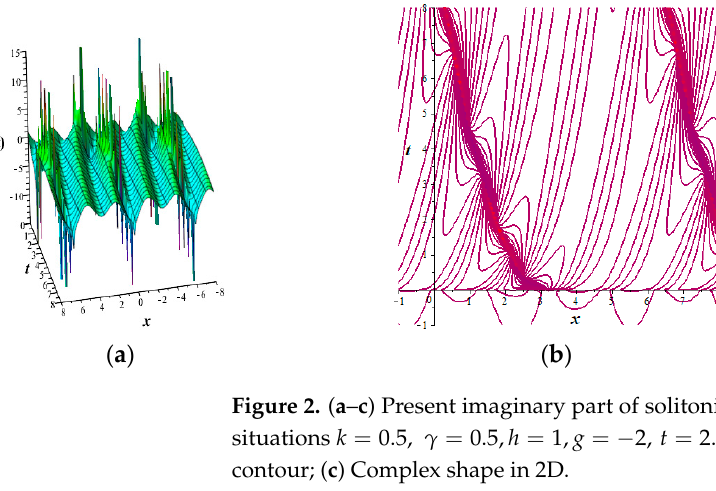
Figure 1. ( a – c ) Representation of real part of wave ),( tx −==== ghk γ situations 2,1,5.0,5.0 Real shape in contour; ( c ) Real shape in 2D.